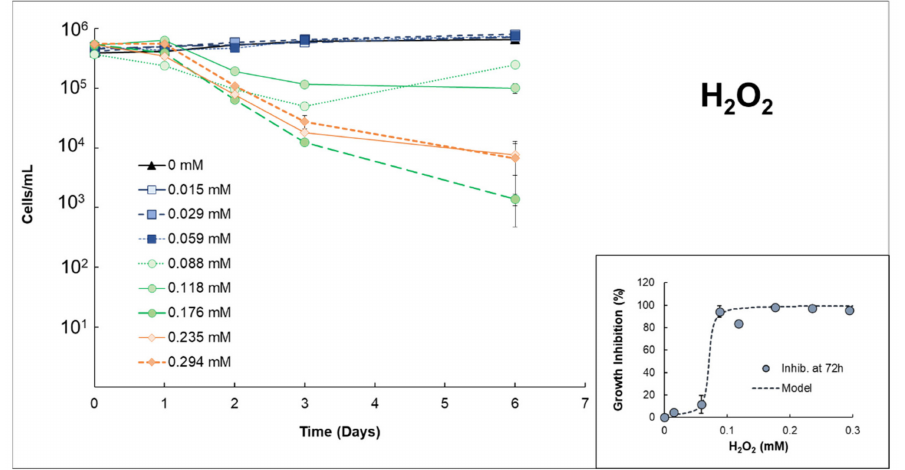
Figure 1. Growth curves of Anabaena sp. after adding different concentrations of H 2 O 2 . Inset: Growth inhibition rate at 72 h for Anabaena sp. exposed to H 2 O 2 . The line plotted corresponds to the fit of the model used (see Section 2.3. Data treatment).